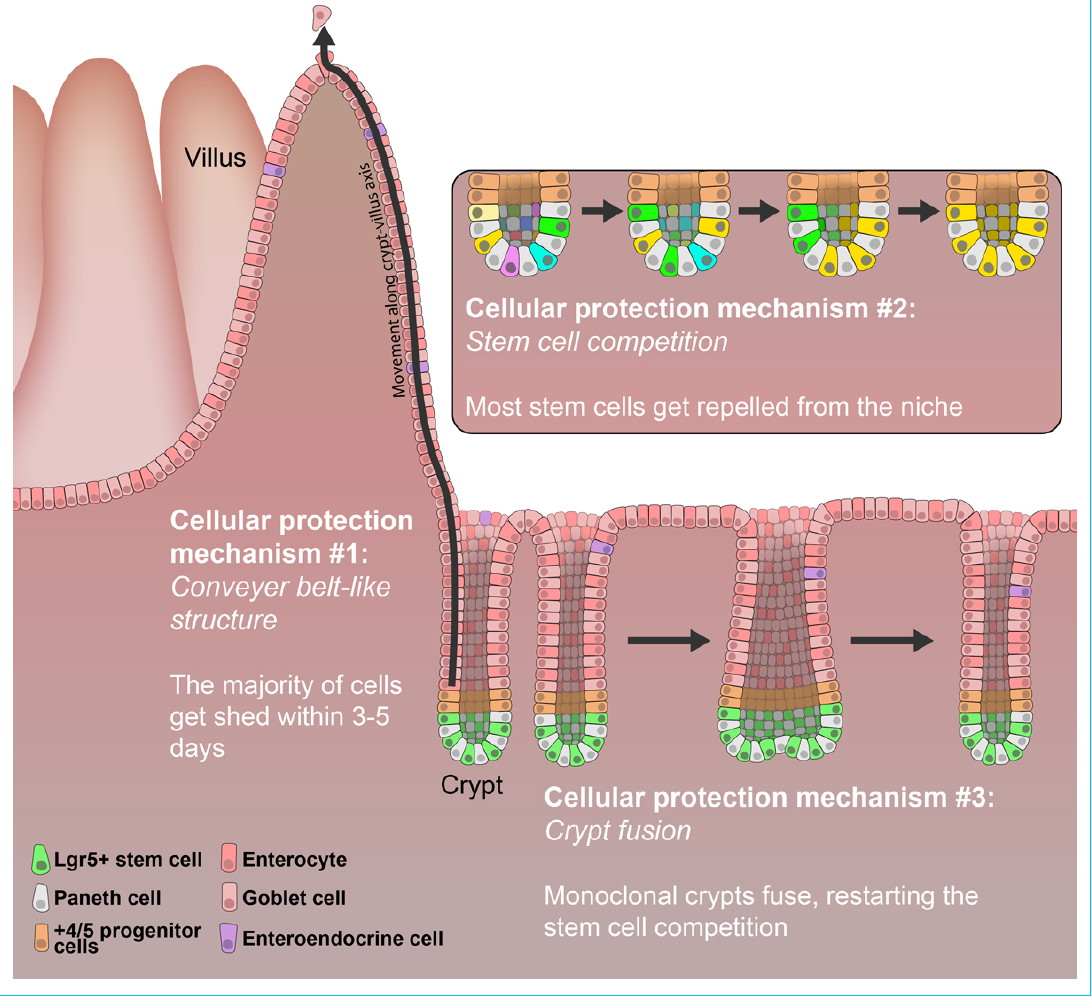
Figure 1: The cellular protection mechanisms against the accumulation of mutations. Cartoon of the crypt-villus units of the small intes- tine. Shown are the three protection mechanisms: 1. conveyer belt-like structure, 2. stem cell competition and 3. crypt